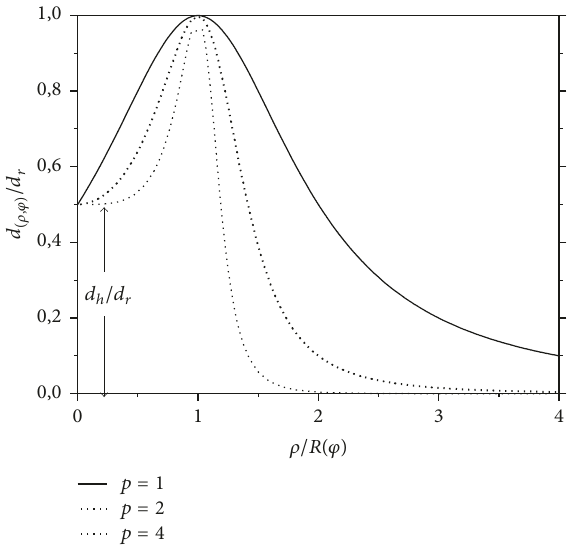
Figure 1: Profiles of radial cross